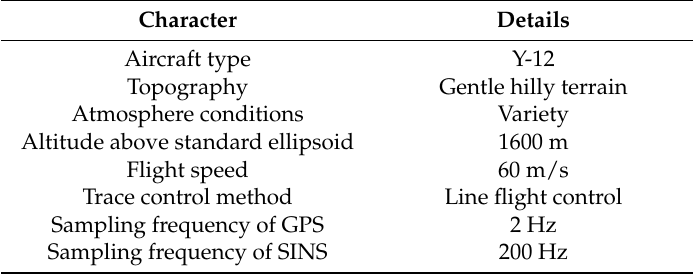
Table 2. The characters of flight.